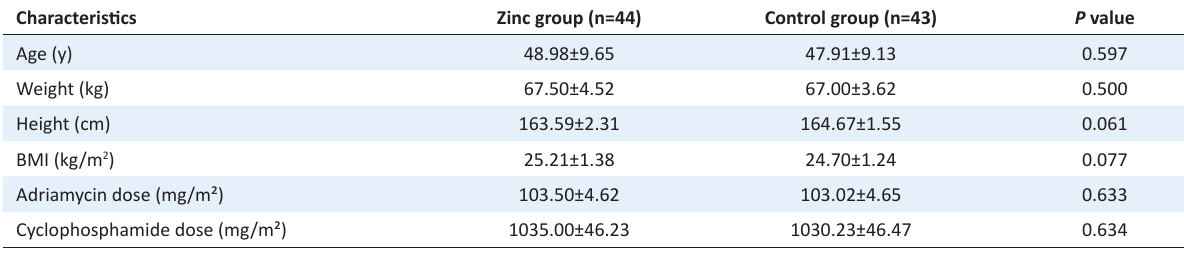
Table 1. Patients’ basic and clinical characteristics in the two groups